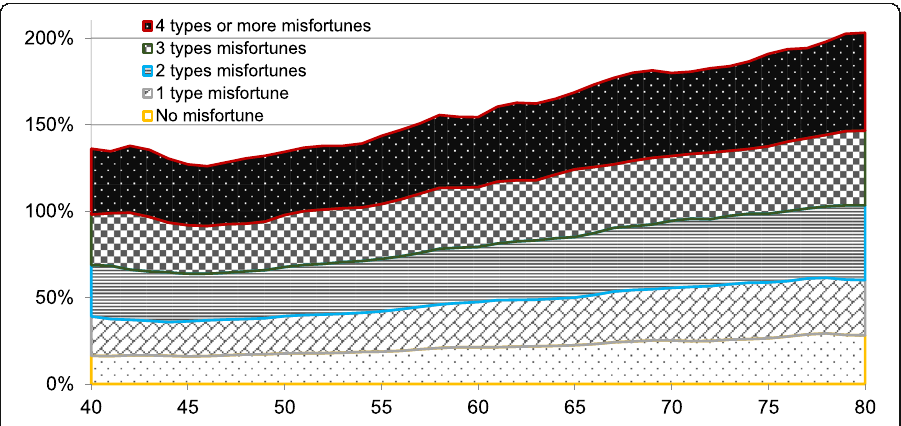
Fig. 2 An area map of the type of early life adversity and the probability of poor health (predicted value)